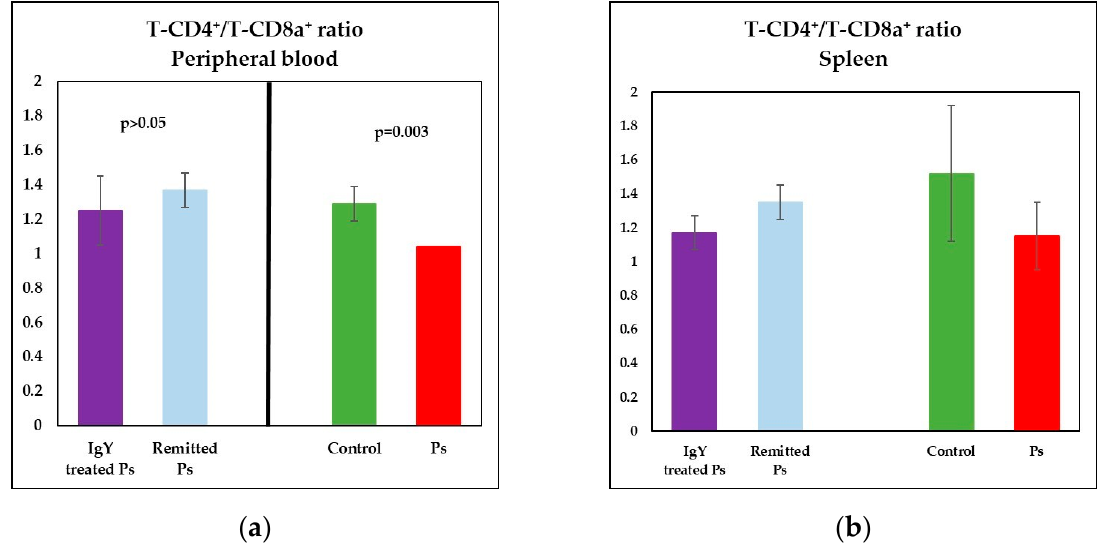
Figure 5. Distribution of T-CD4 + /T-CD8a + ratio in peripheral blood and spleen cell suspension. ( a ) Peripheral blood- distribution of T-CD4 + /T-CD8a + ratio for IgY-treated Ps group ( n = 12) (1.25 ± 0.2) as compared to naturally remitted Ps group ( n = 8) (1.37 ± 0.1), control group ( n = 8) (1.29 ± 0.2) and Ps group ( n = 8) (1.04 ± 0.1); ( b ) Spleen cell suspension– distribution of T-CD4 + /T-CD8a + ratio for IgY-treated Ps group ( n = 12) (1.17 ± 0.1) as compared to naturally remitted Ps group ( n = 8) (1.35 ± 0.1), control group ( n = 8) (1.52 ± 0.4) and Ps group ( n = 8) (1.15 ± 0.2). The results are presented as mean ± SD; n = number of mice).